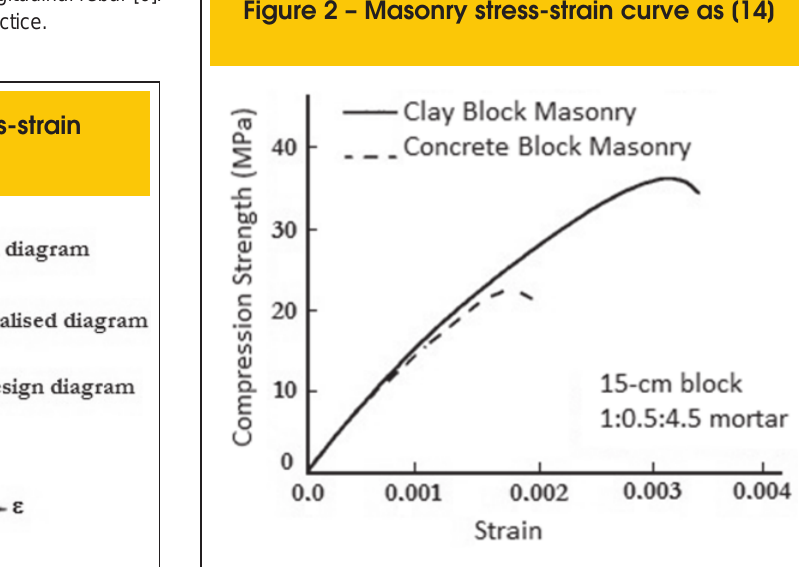
Figure 2 – Masonry stress-strain curve as